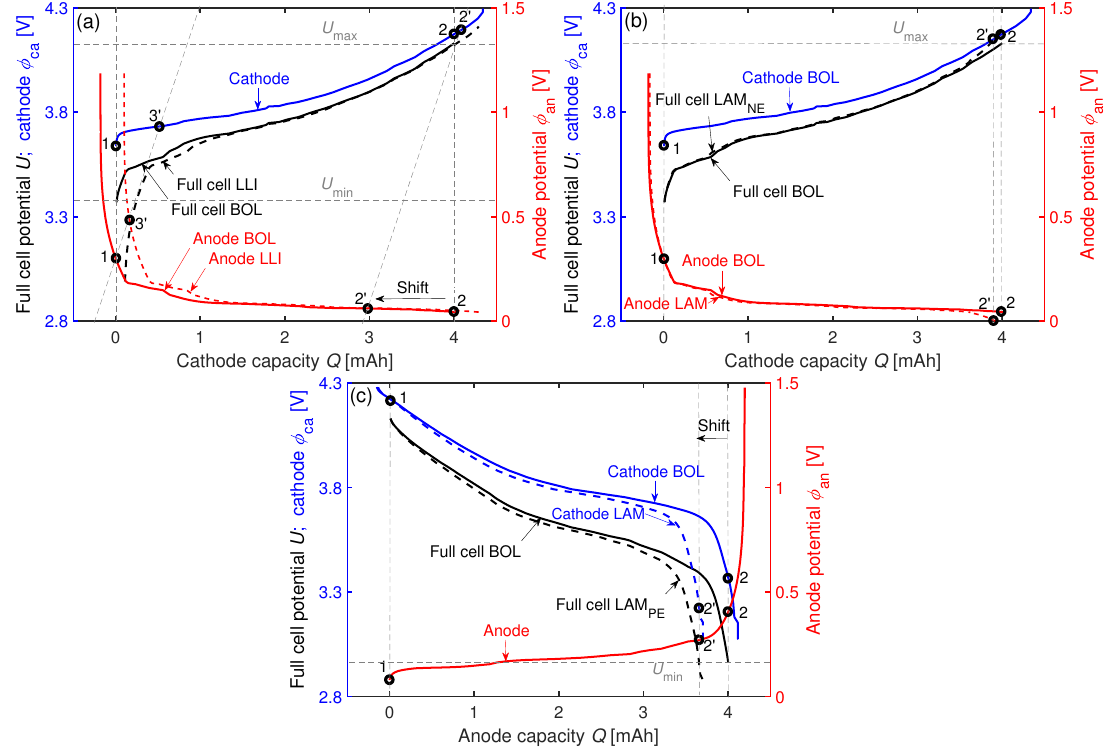
Figure 3. Exemplarly impacts of ( a ) LLI, ( b ) LAM NE , and ( c ) LAM PE on the electrode balancing (e.g., the maximum and minimum anode potentials φ max an , φ min an ) of a measured coin